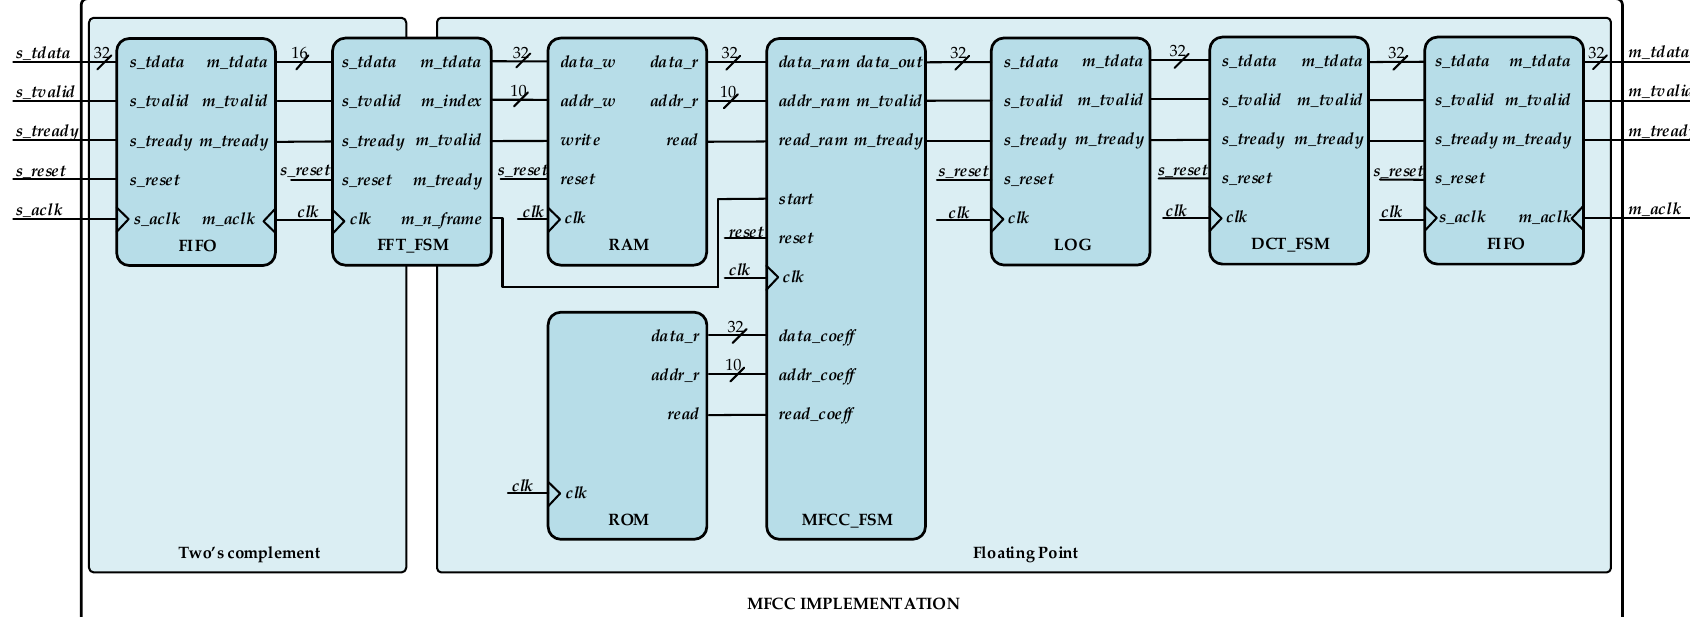
Figure A1. Main block diagram of the proposed Fiel Programmable Gate Array (FPGA)